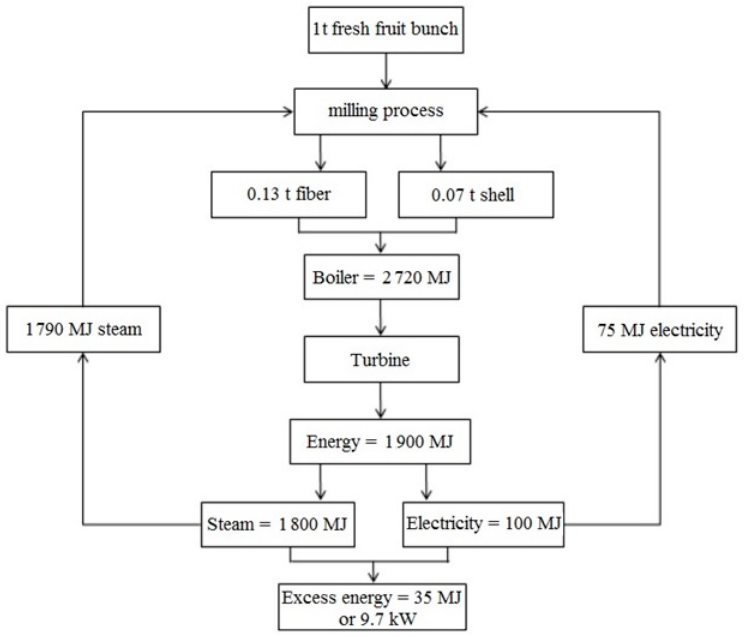
Figure 2. Energy excess of the potential energy of palm oil.